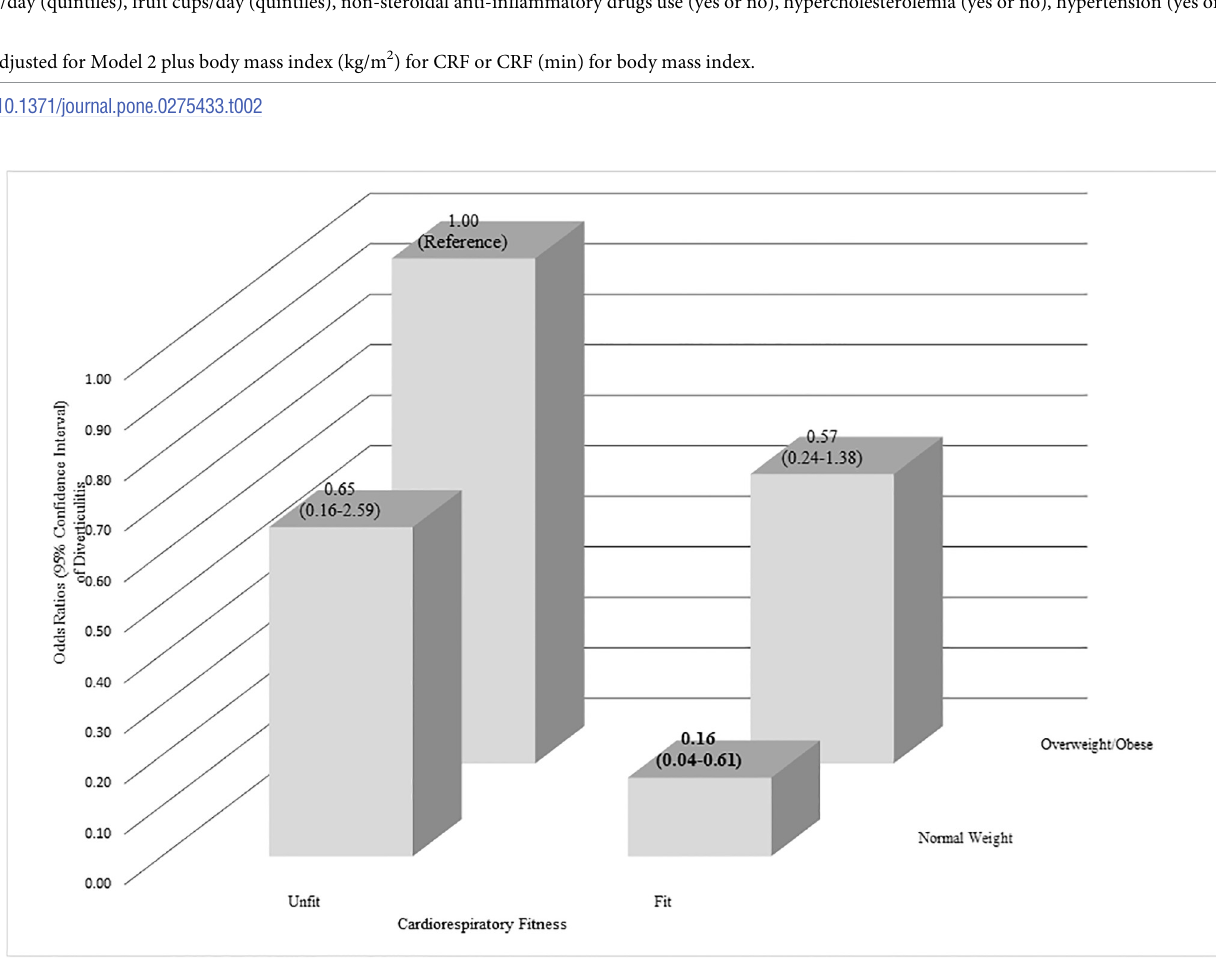
Fig 1. Joint associations of cardiorespiratory fitness and body mass index with